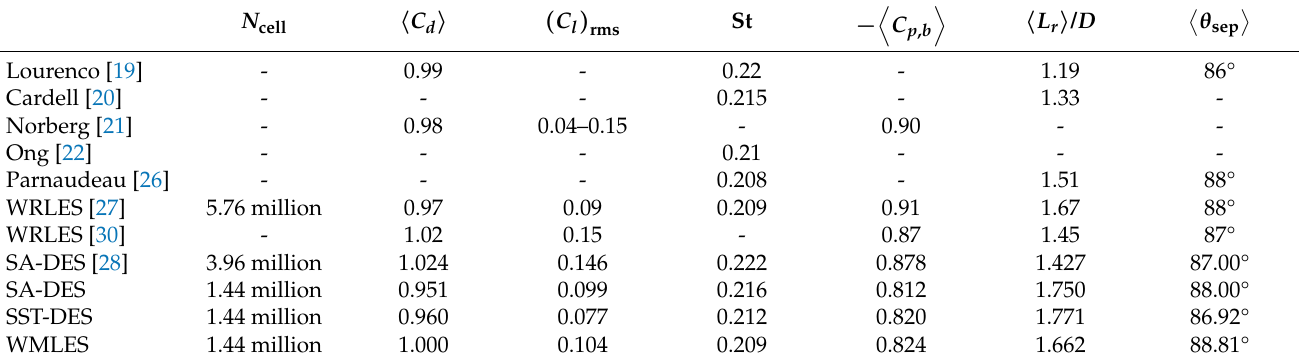
× Figure 8. Power spectra of the normal velocity u y at ( 3 D ,0, π /2 ) in the wake. Table 2. Integrated flow quantities for the flow over the cylinder at Re D =